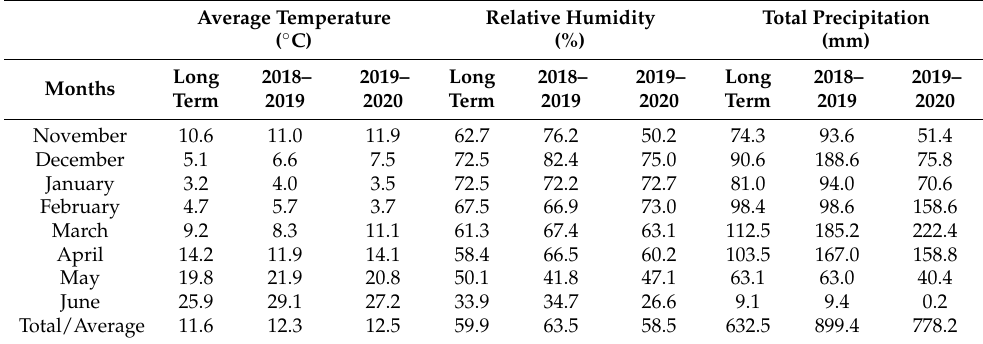
Table 1. Climatic data of the research site for long term (1981–2019) and research years [27].